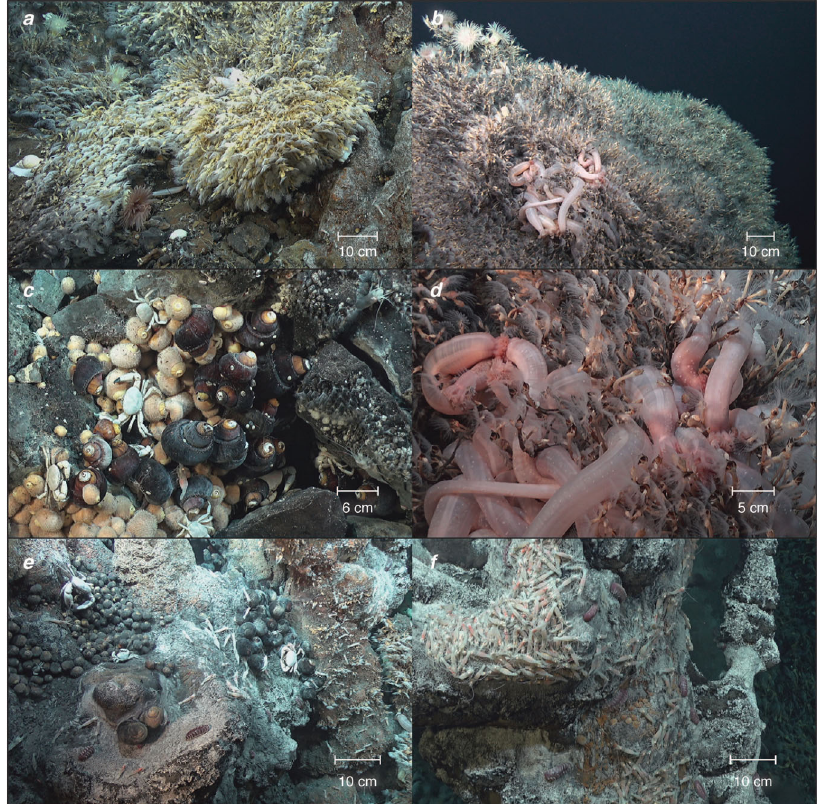
Fig. 5 Hydrothermal fauna from La Scala Vent Field. a Vulcanolepas sp. n. thickets, anemones and gastropod Phymorhynchus sp. b Anemones and holothurian Chiridota sp. in Vulcanolepas sp. n. thickets. c Aggregation of gastropods Ifremeria nautilei and Alviniconcha kojimai with Austinograea crabs and cirripeds Eochionelasmus ohtai and Imbricaverruca sp. (right side of the picture). d Chiridota sp. in Vulcanolepas sp. n. thicket. e Aggregation of Alviniconcha kojimai , polynoids, alvinocarids shrimps, and Austinograea crabs. f Aggregation of alvinocarid shrimp Rimicaris variabilis , polynoids Branchinotogluma segonzaci and gastropod Shinkailepas tufari on active